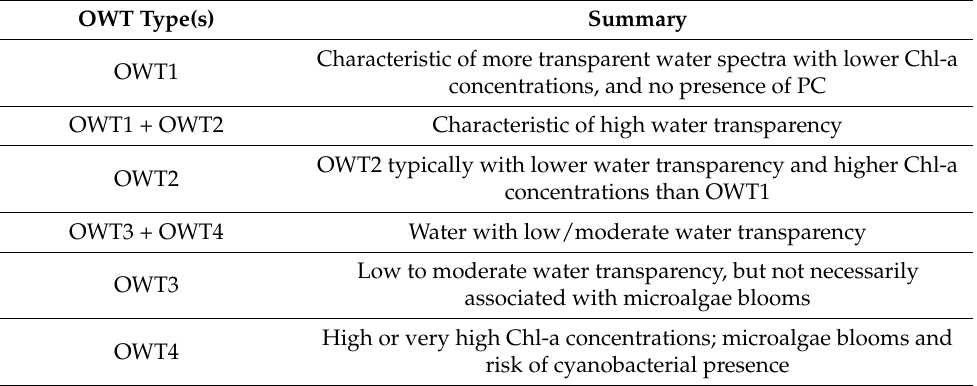
Table 5. Summary of key findings from the four defined OWTs. Water turbidity and Chl-a concentra- tions increase from cluster OWT1 to